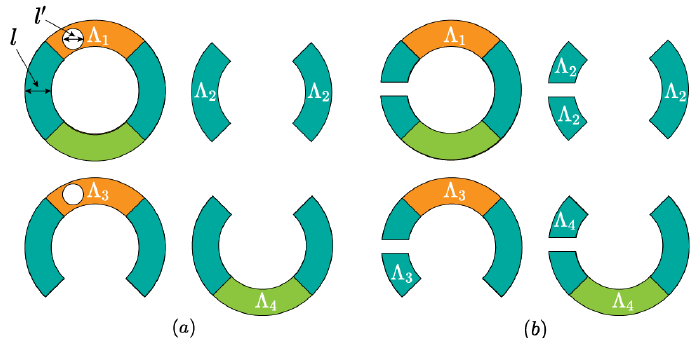
Figure 7: Pictorial representation of l − genuine topological difference. The typical size of the sketched domain is l . ( a ) A l (cid:48) patch has been applied to the sets of domains E Λ and since l (cid:48) < l the sets shows the same genuine topological difference, indeed Λ 1 2 ) = 3 + 2, n ( E ) = 2 + 1 and n n ∂ ( E Λ Λ ∂ Λ Λ 1 2 3 4 6. ( b ) the sets are patched with a patch whose size is l (cid:48) ≥ l which change the genuine topological difference, indeed n ∂ ( E Λ ) − n ( E ) = 0 (cid:54) = n ∂ ( E Λ Λ ∂ Λ Λ 1 2 3 4